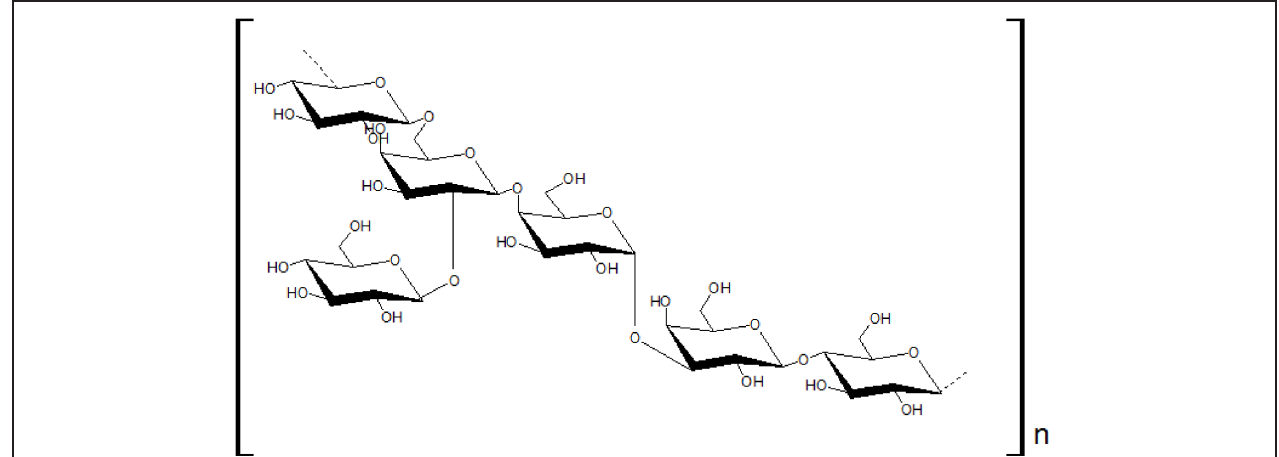
FIGURE 1 | Kefiran